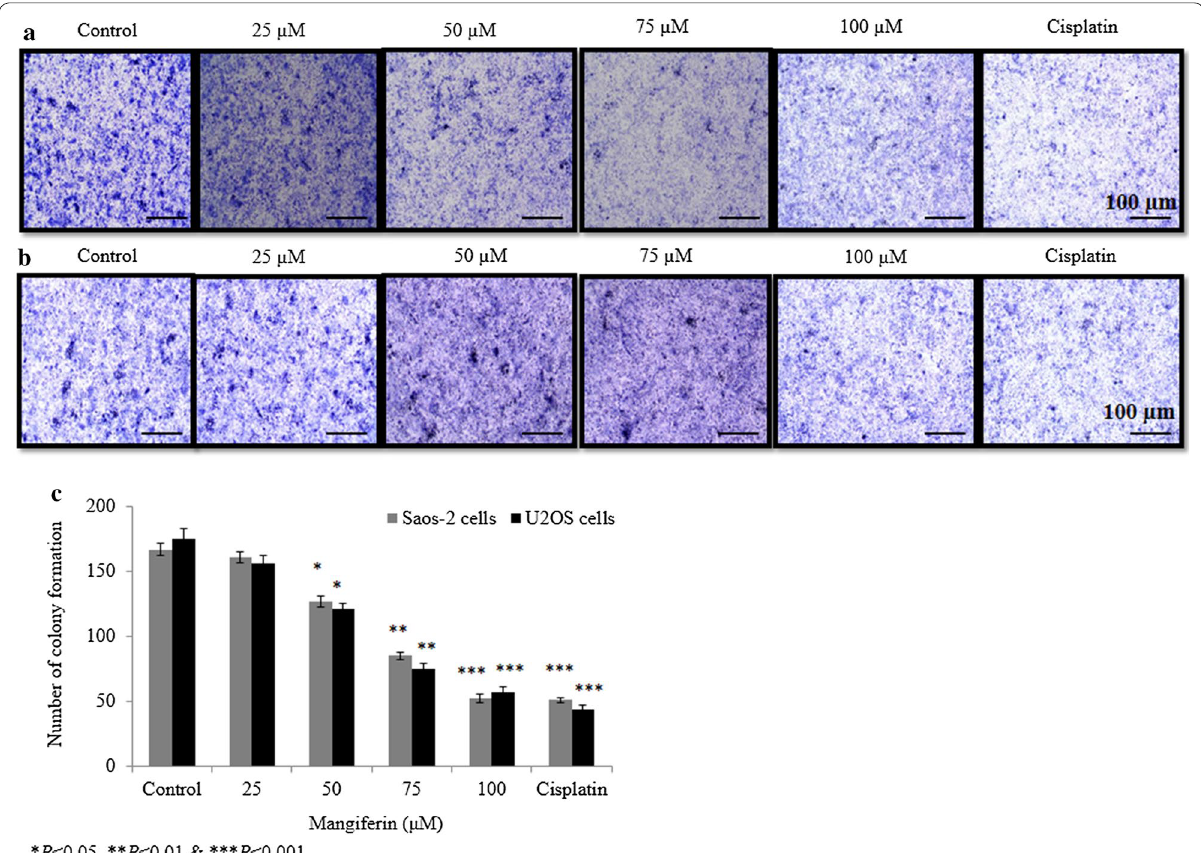
Fig. 2 Effect of mangiferin on the ability of osteosarcoma cells to form colonies. Cells were incubated with mangiferin (25–100 µM) for 72 h. a Saos-2 cell colony formation assay, b U2OS colony formation assay and c percentage analysis of a and b. N 100